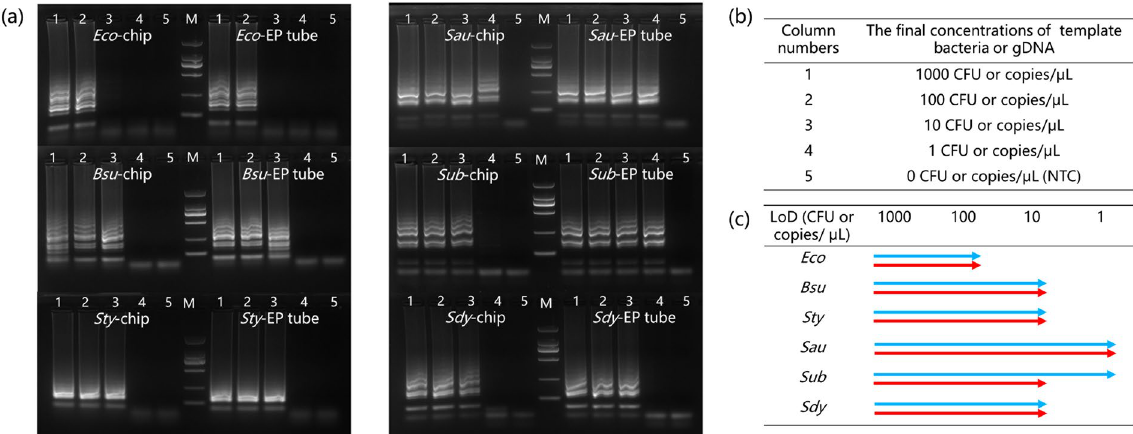
Figure 5. The on-chip and in-tube LoDs of six kinds of bacteria. ( a ) Electrophoretograms of each amplification product with different concentrations of template. Lane marked M represents the DNA marker. The molecular weights of the bands (from the top to bottom) are 2000, 1000, 500, 250, and 100 bps, respectively. ( b ) Concentrations of template in each column. ( c ) Diagram of the on-chip (red arrows) and in-tube (blue arrows) LoD of six kinds of bacteria.